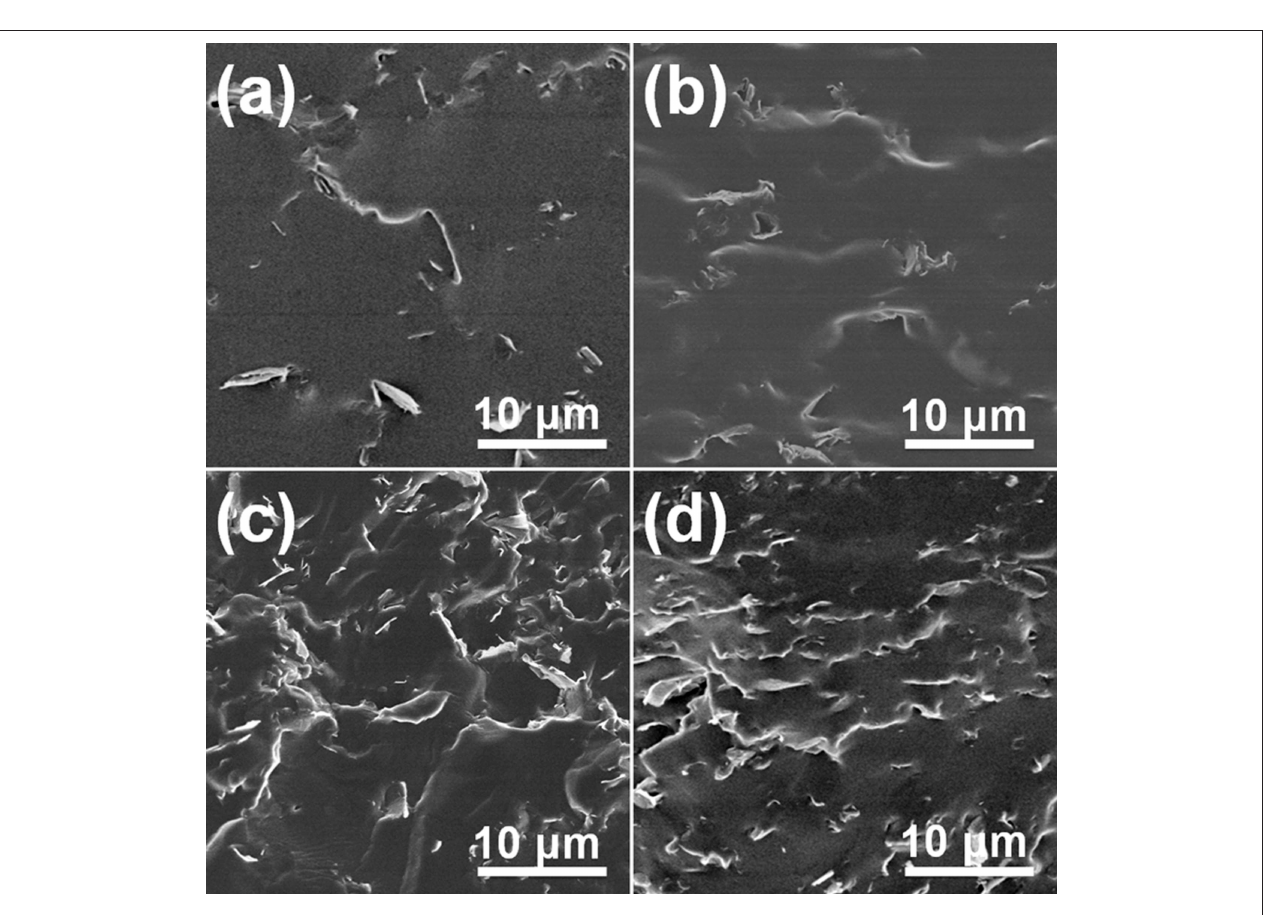
FIGURE 6 | SEM images of aGnP/epoxy with (a) 1 wt% and (c) 3 wt% GnP, and hGnP/epoxy with (b) 1 wt% and (d) 3 wt%